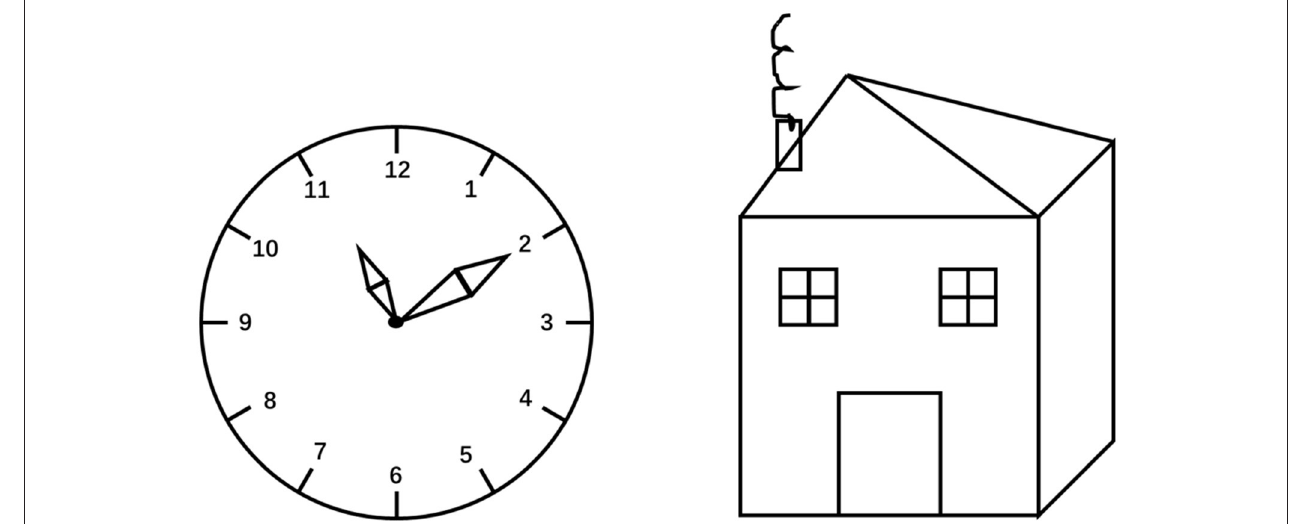
FIGURE 3 | Clock and house drawing tasks.